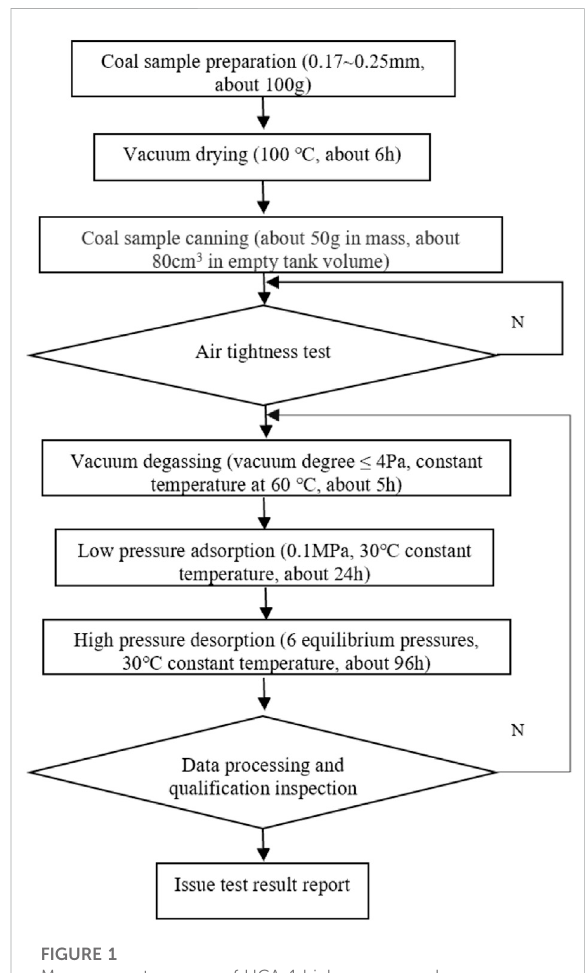
FIGURE 1 Measurement process of HCA-1 high pressure volume gas adsorption